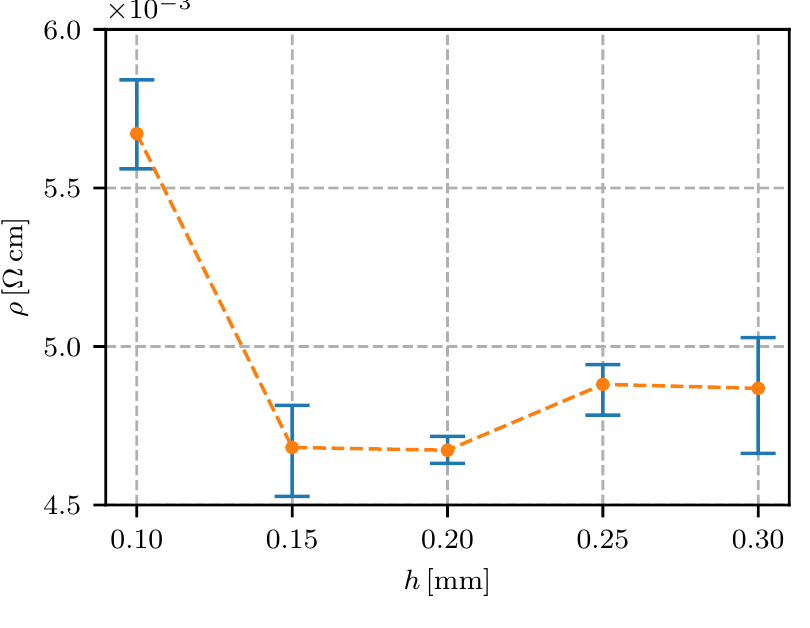
Figure 11. Resistivity for different layer heights h .